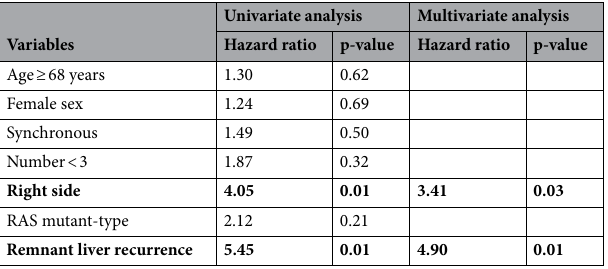
Table 2. Univariate and multivariate analyses of OS. Significant values are in